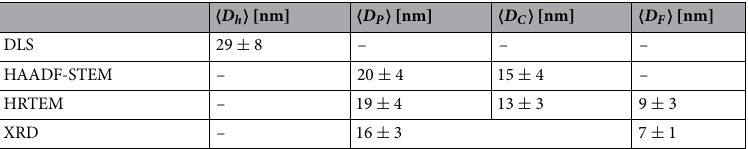
D h , particle diameter (cid:31) (cid:30)